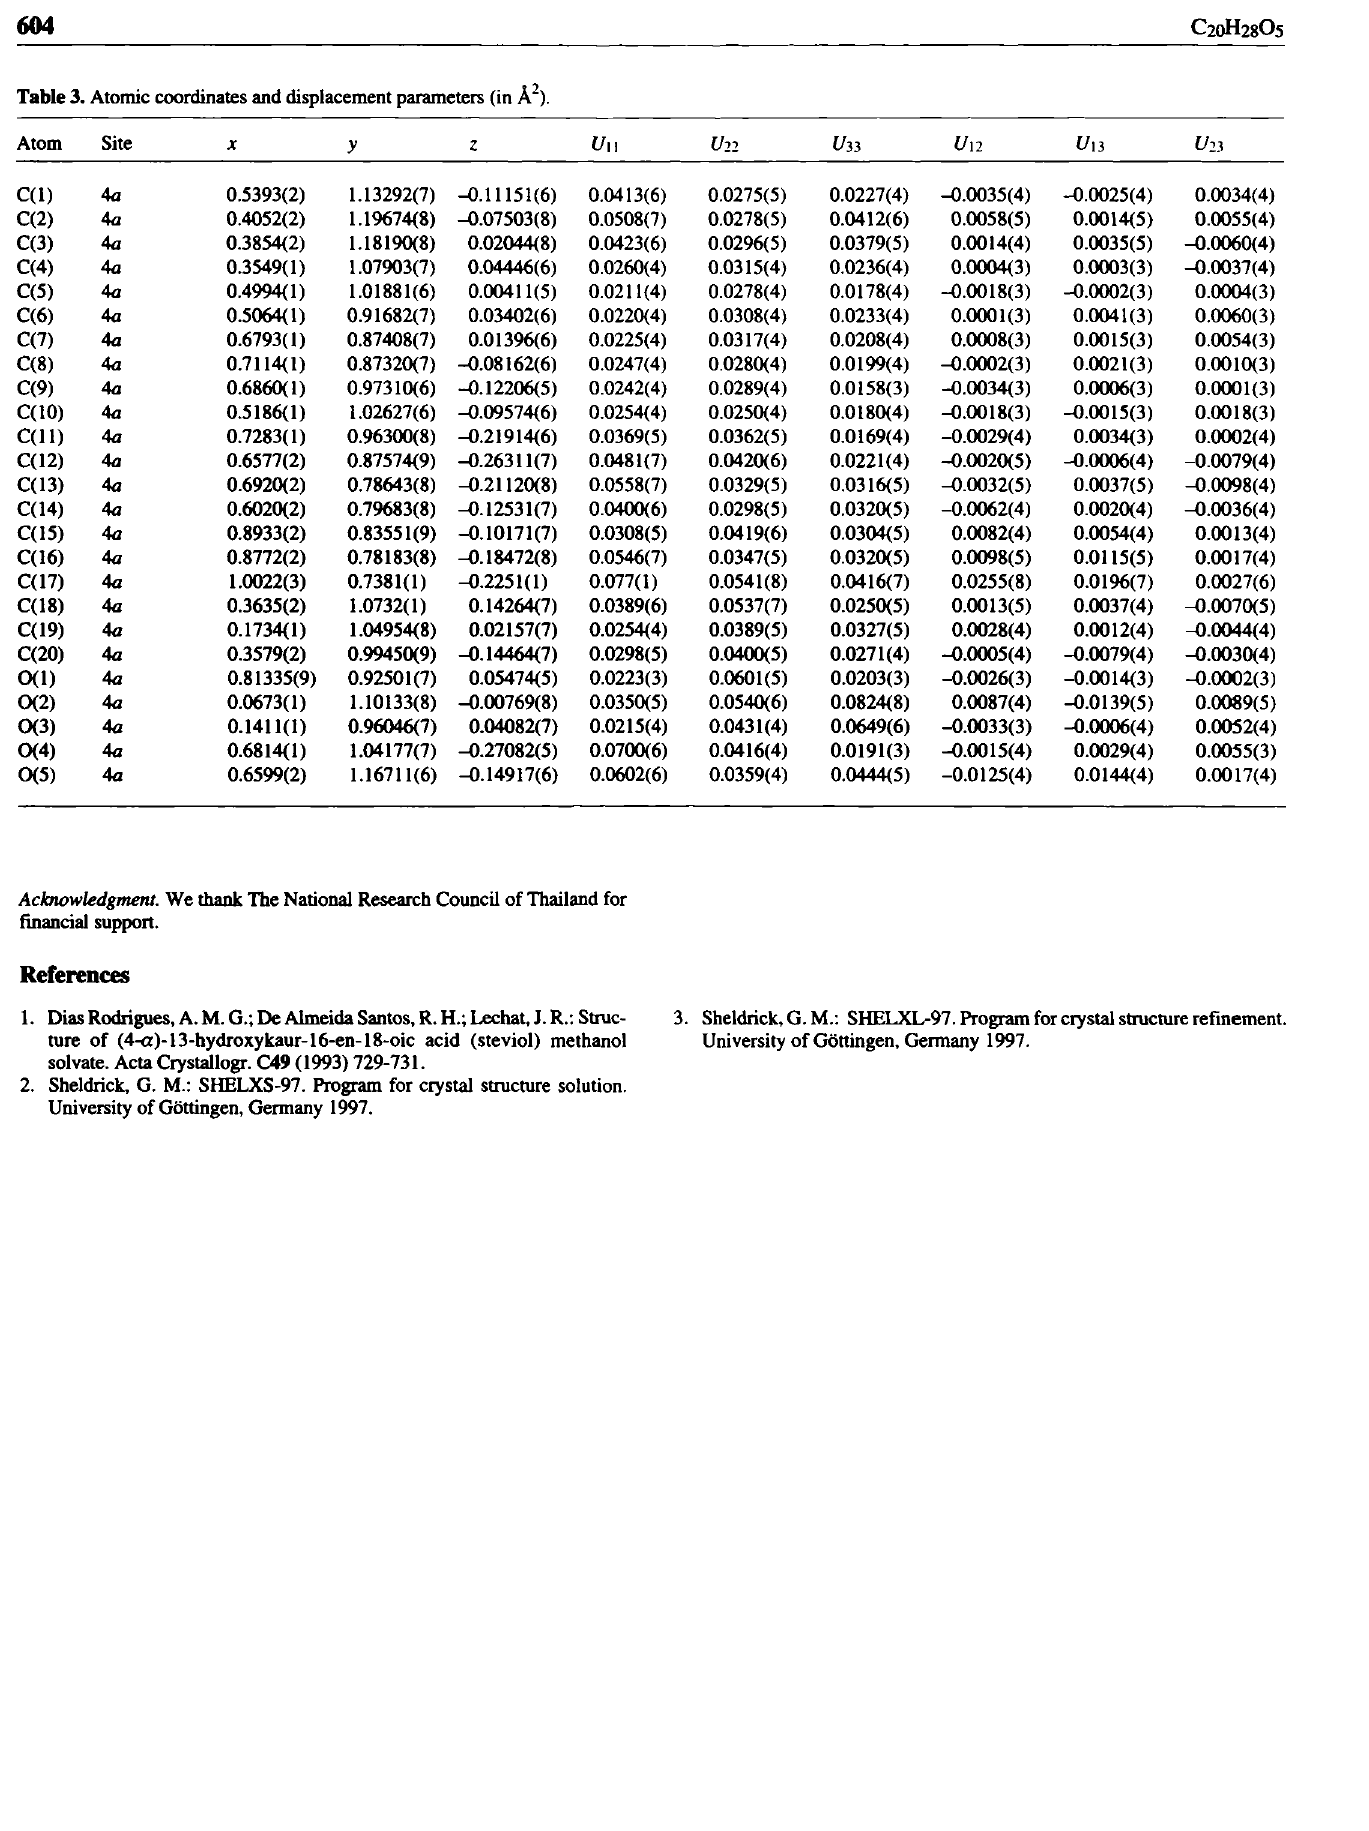
Table 3. Atomic coordinates and displacement parameters (in À 2